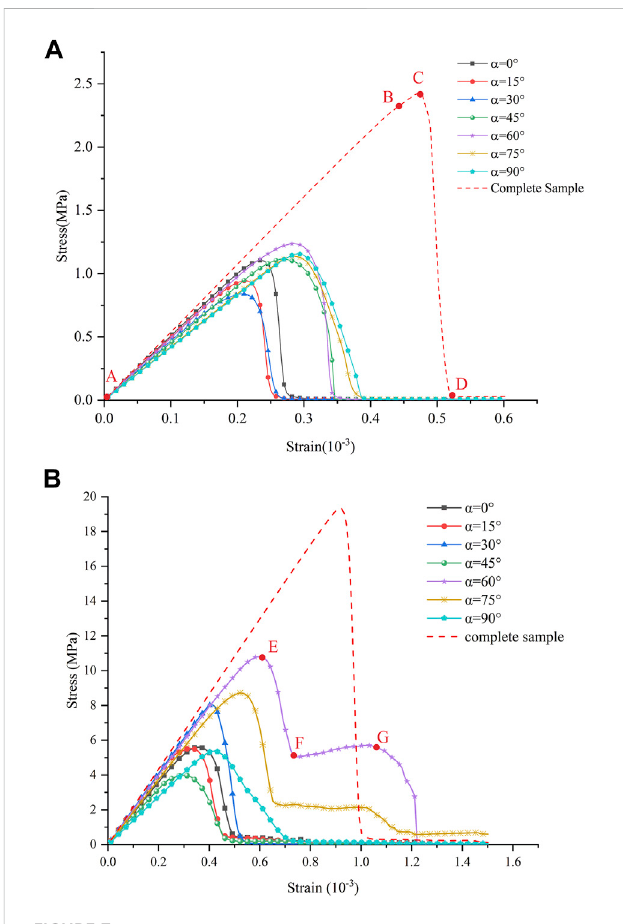
FIGURE 7 Numerical simulation test stress-strain curve. (A) Sample containing quartz. (B) Sample without